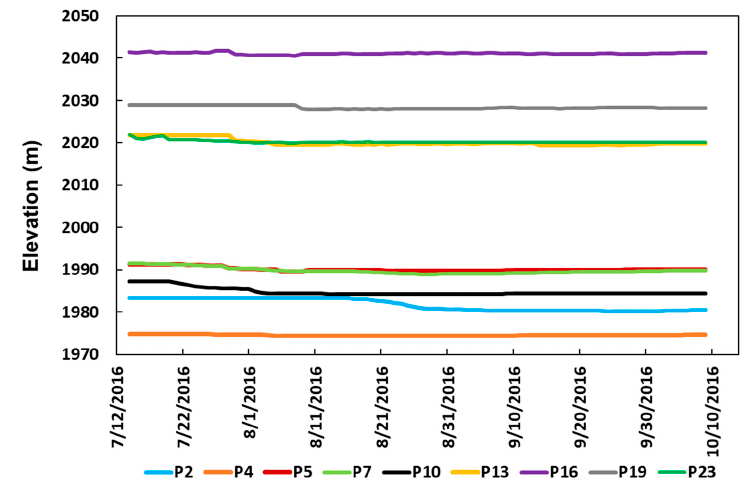
Figure A2. Piezometer water levels are plotted as a function of elevation above sea level. The well locations are given in Table A2.